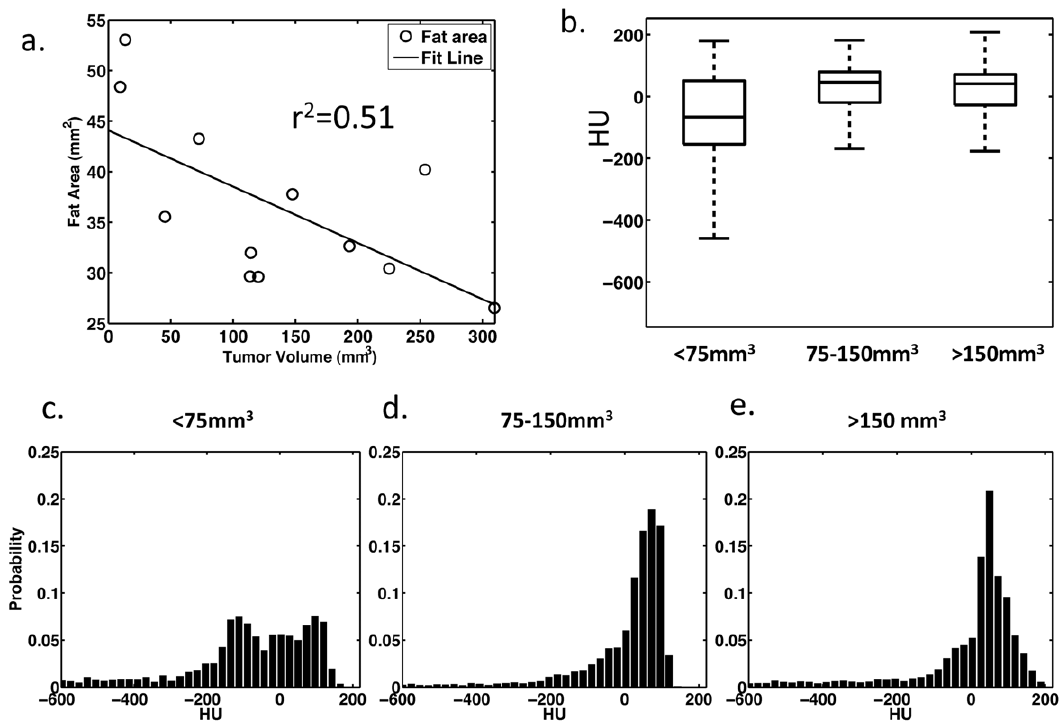
Figure 5. HU accurately predicts the tumor fat content. (a) Fat, as measured from histological slices, decreases with increasing tumor area (r 2 =0.51, slope= 2 0.3). (b) Box plot of average CT histograms show the fat shifted HU values in small tumors. (c–e) Average histograms of tumors in three tumor size groups show the presence of a tail in the range of HU associated with fat. Based on CT images and histology, fat content decreases with increasing tumor volume.